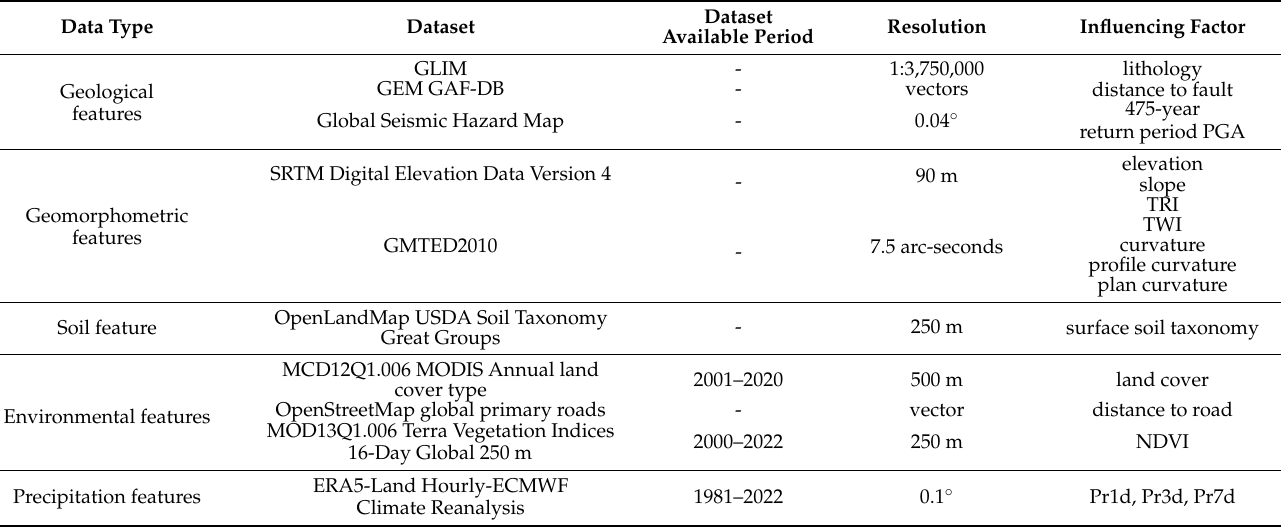
Table 1. Datasets and corresponding landslide influencing factors. The symbol “-” indicates that the data has no time-series